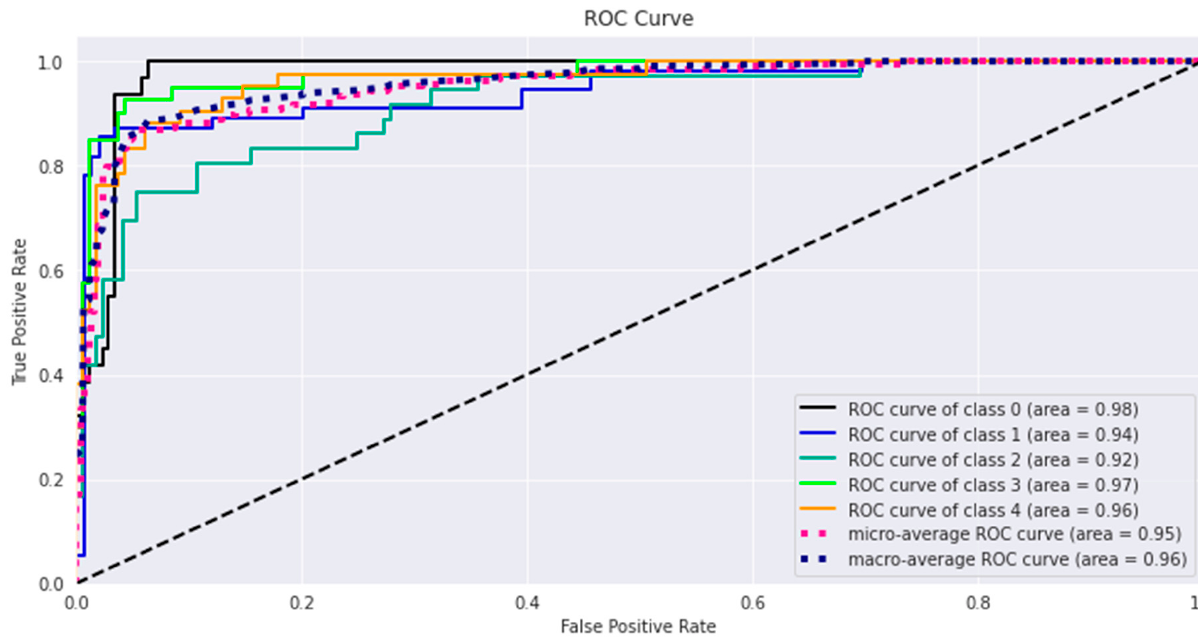
Figure 10. Confusion matrix gives inside of classification model on random configuration.